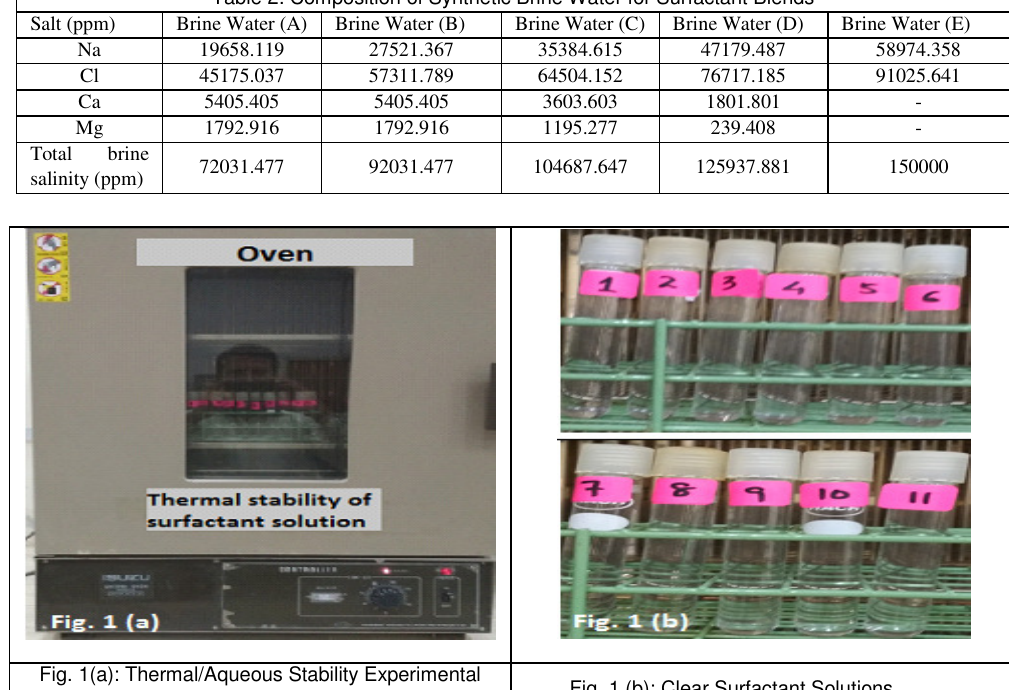
Fig. 1(a): Thermal/Aqueous Stability Experimental Setup